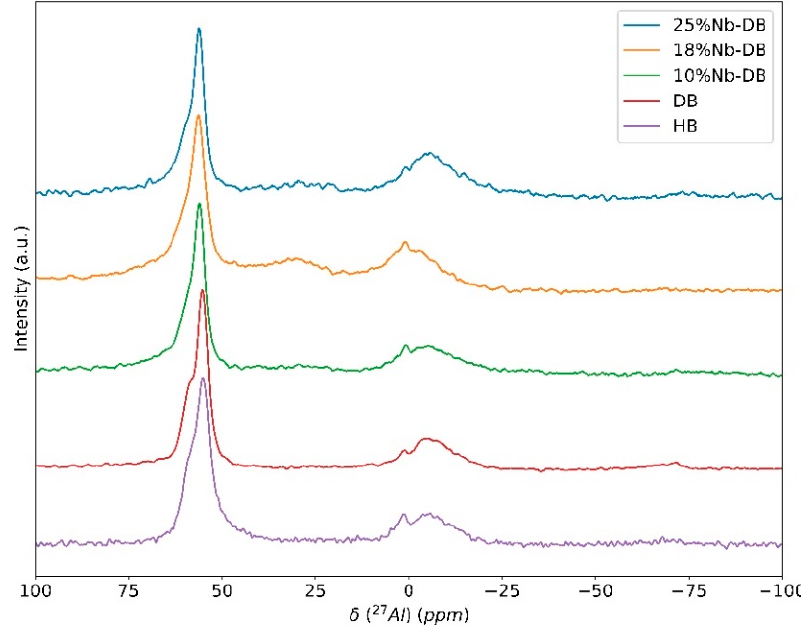
Figure 4. 27 Al MAS NMR spectra of the catalysts. Table 4. Relative distribution of tetrahedral (Al-Td) and octahedral (Al-Oh) aluminum, and Q 4 and Q 3 environments of silicon, based on areas of Al signals and deconvolution of Si spectra.